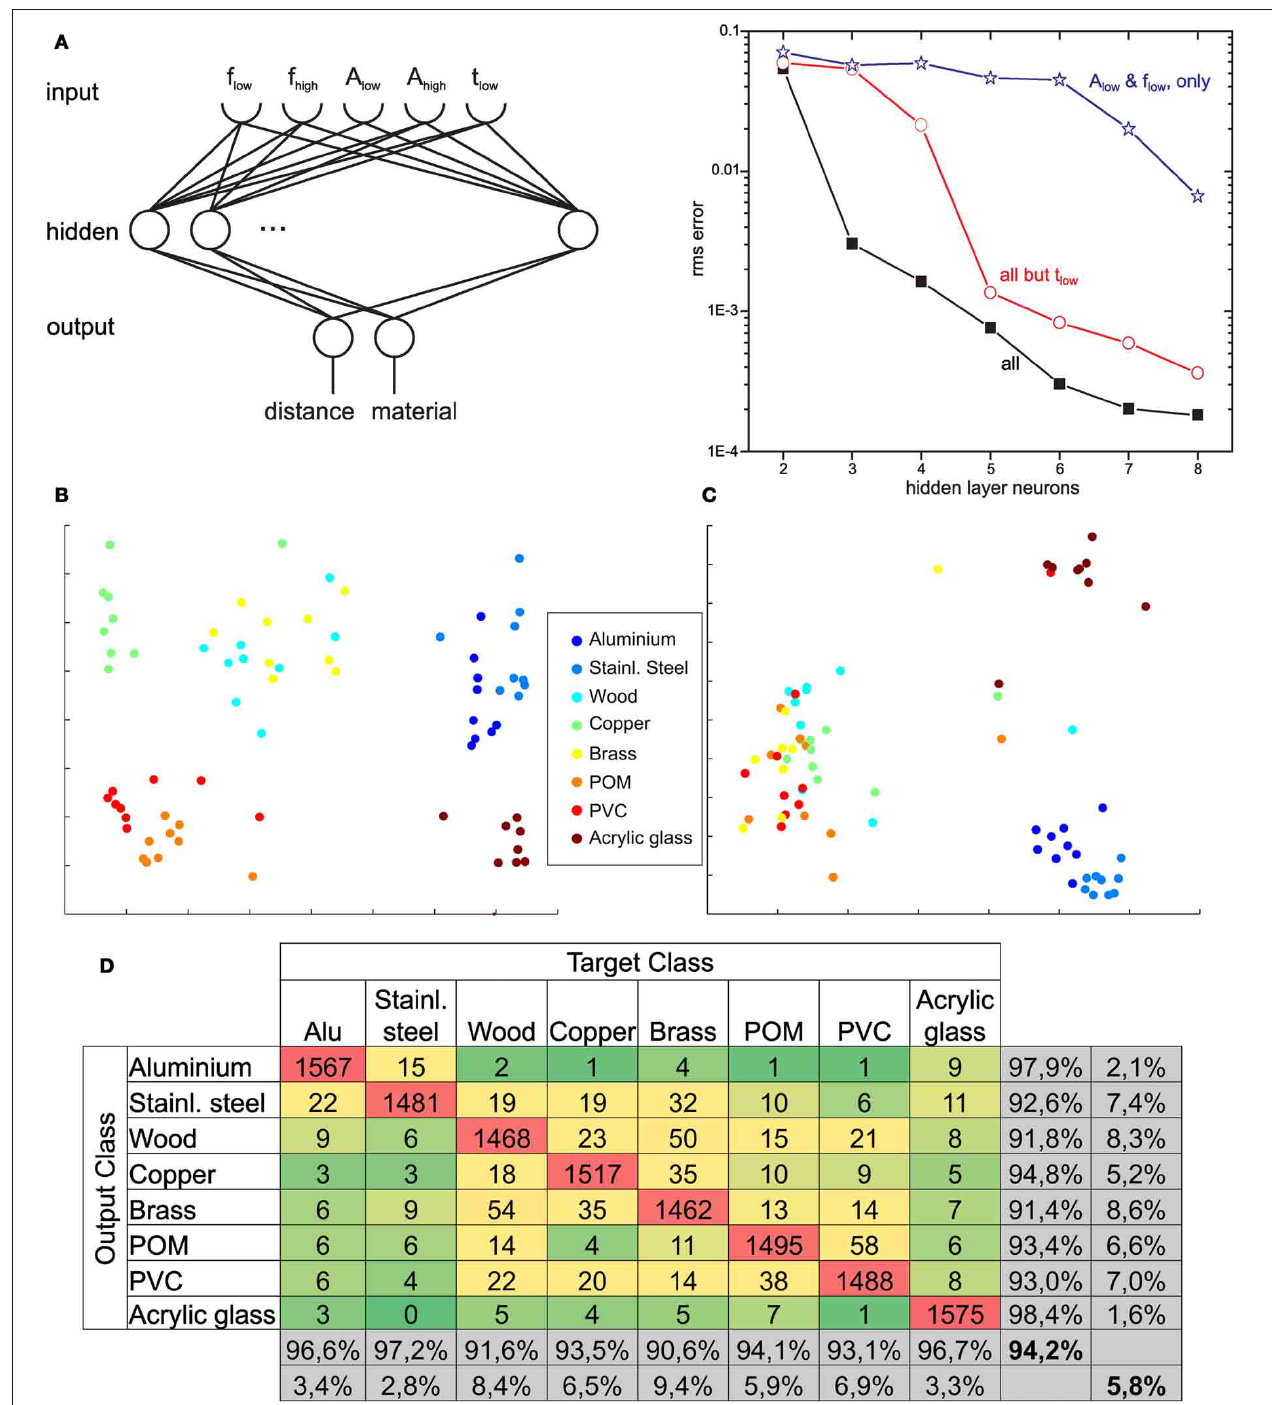
included as input. (B) and (C) illustrate the separability of different materials. The Fourier spectra of eight materials with a contact distance of 80mm (B) and 320mm (C) were graphed using multi-dimensional scaling, resulting in a two-dimensional embedding with pair-wise distances being conserved. (D) Confusion matrix, showing the output of the ANN compared to the true material class. As expected from multi-dimensional scaling, some materials could be distinguished easily, e.g., copper and aluminium, whereas others were more challenging, e.g., brass and